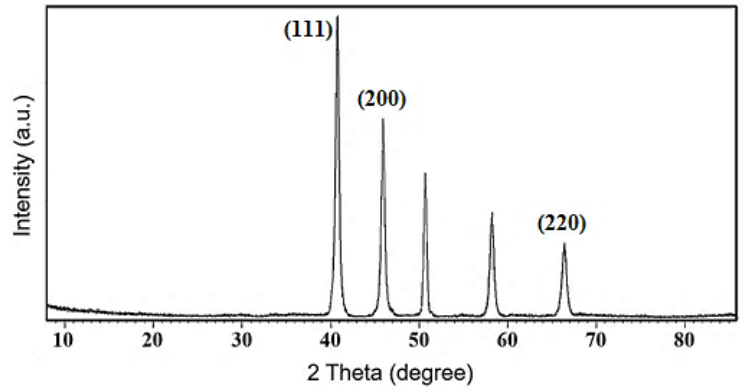
Figure 3. X-ray Diffraction (XRD) pattern of Pd NPs.